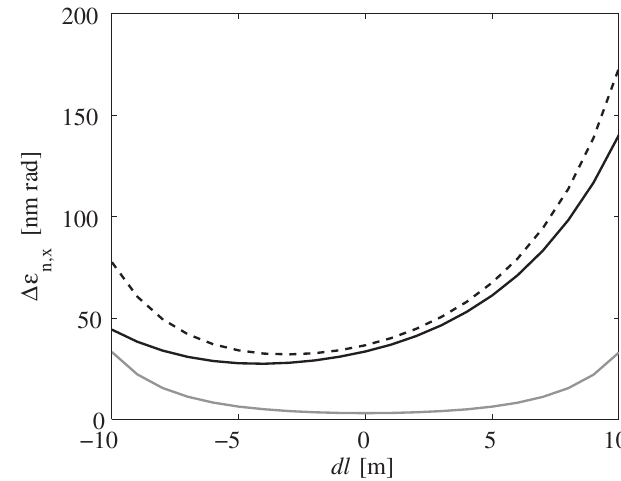
FIG. 8. Variation of ISR (gray), CSR (black), and ISR (cid:5) CSR (dashed) emittance growth with the position of the central di- poles in a C-chicane.